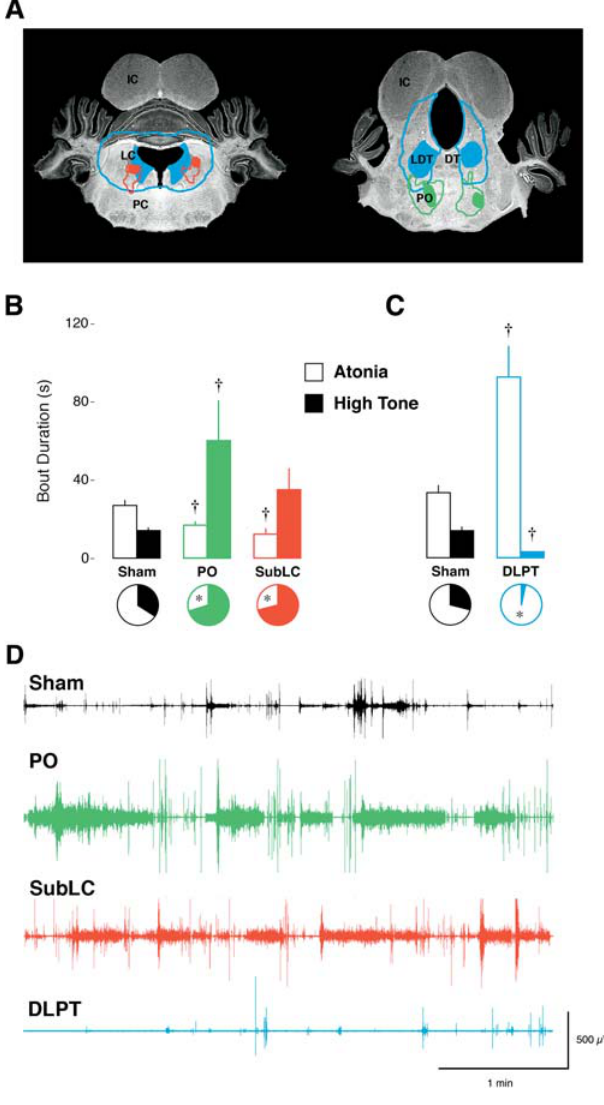
Figure 8. Effects of Brainstem Lesions on the Expression of Nuchal Muscle tone in P8 Rats (A) Representations of lesions of the dorsolateral pontine tegmentum (DLPT; blue), pontis oralis (PO; green), and subcoeruleus (SubLC; red) on coronal sections. Outlined areas indicate the extent of all lesions in a group, and filled areas indicate the smallest lesion in a group. (B) Mean 6 standard error bout durations of atonia and high muscle tone for sham ( n = 7; black), PO lesion ( n = 5; green), and SubLC lesion ( n = 4; red) groups. (cid:1) Significant difference from sham group, p , 0.05. Pie charts beneath each bar graph indicate percentage of time spent in atonia or high muscle tone. * Significant difference from sham group, p , 0.05. (C) Mean 6 standard error bout durations of atonia and high muscle tone for sham ( n = 7; black) and DLPT lesion ( n = 6; blue) groups. (cid:1) Significant difference from sham group, p , 0.05. Pie charts beneath each bar graph indicate percentage of time spent in atonia or high muscle tone. * Significant difference from sham group, p , 0.05. (D) Representative 4-min recordings of nuchal EMG for a sham pup and for pups with PO, SubLC, and DLPT lesions. DT, dorsal tegmental nucleus; IC, inferior colliculus; LC, locus coeruleus; LDT, laterodorsal tegmental nucleus; PC, nucleus pontis caudalis; PO, nucleus pontis oralis DOI: